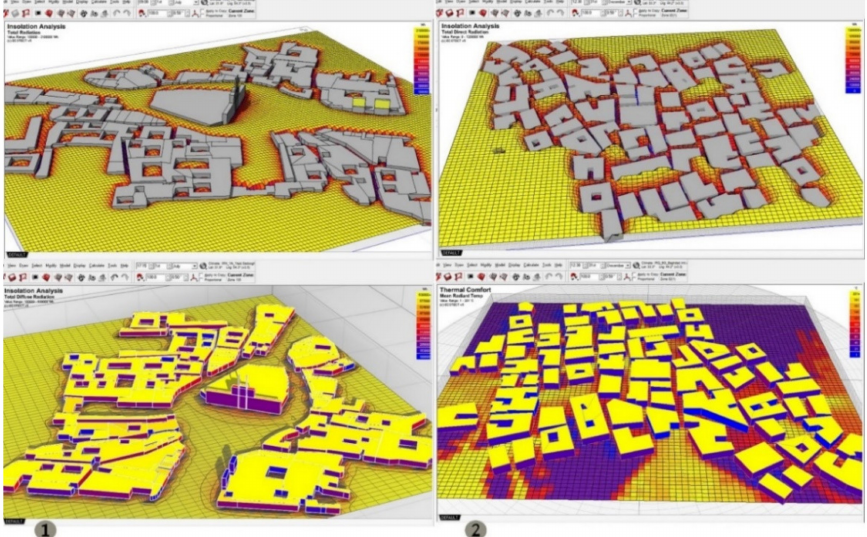
Figure 7. Incident solar analysis of urban fabric in ( 1 ) old Yazd, ( 2 ) old Baghdad.